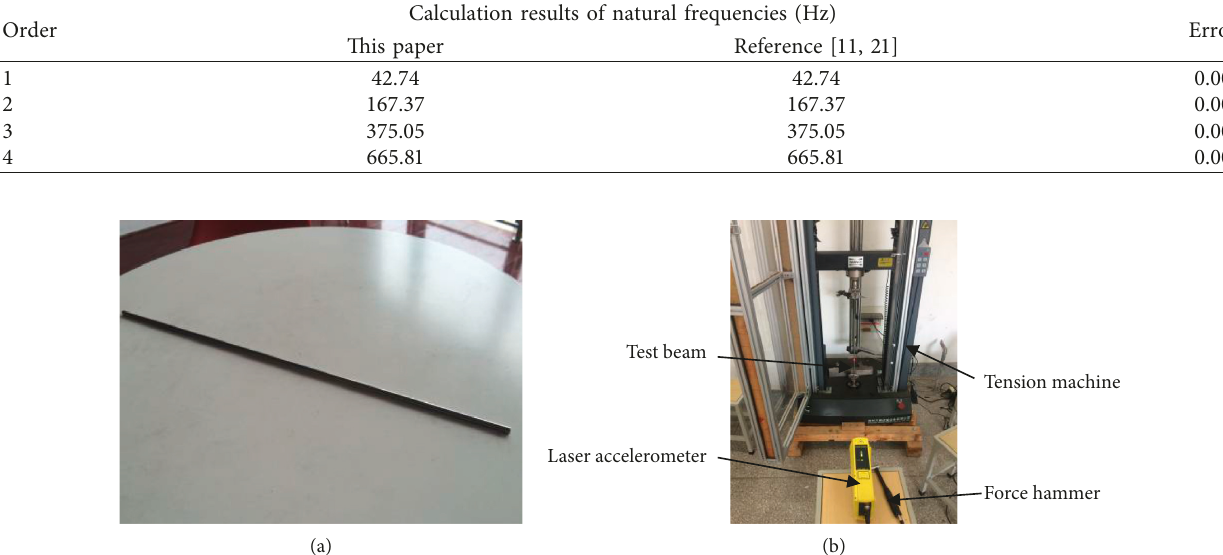
Table 1: Comparison of calculation results of natural frequencies of simply supported beam under axially uniform prestress between two methods. Calculation results of natural frequencies (Hz) Order